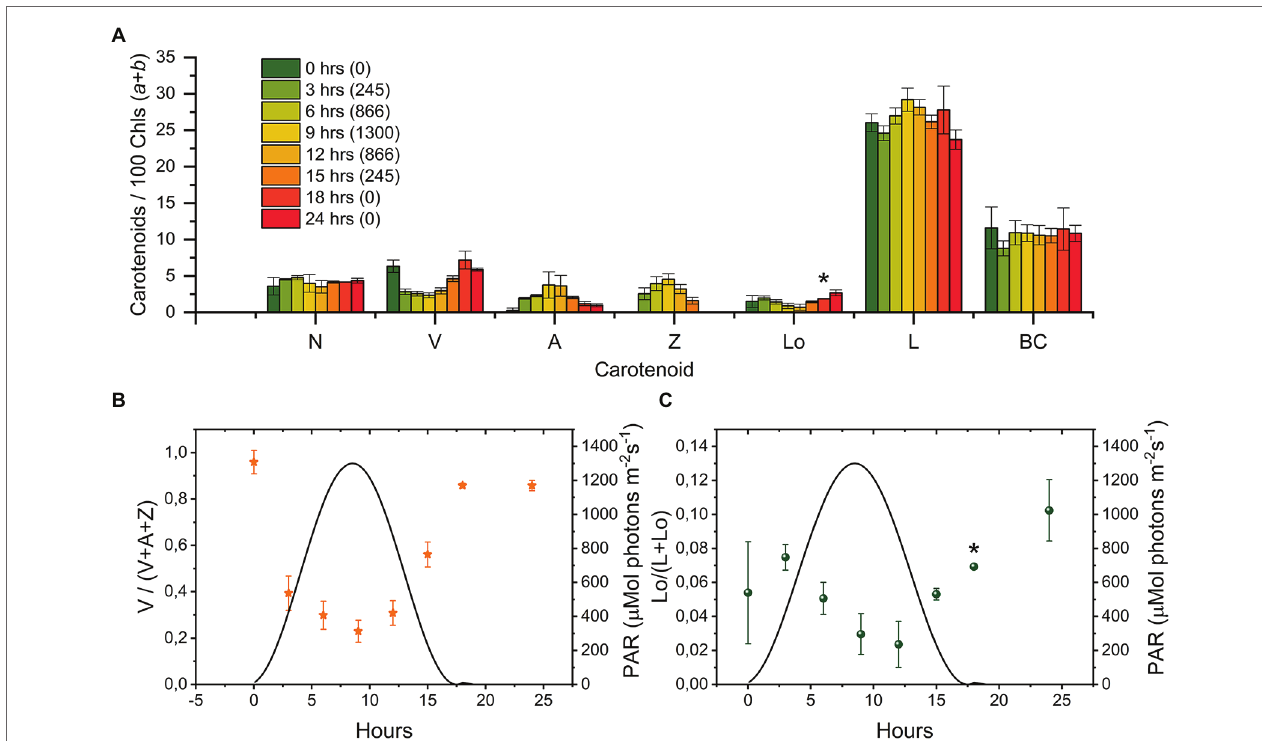
FIGURE 3 | Changes in the carotenoid composition of Chlamydomonas reinhardtii cells during a “simulated summer” day [18:6 (D:N) sinusoidal light regime]. (A) Carotenoid composition relative to 100 Chl ( a + b ) molecules of cultures at different time points (0, 3, 6, 9, 12, 15, 18, and 24 h, the number between brackets in the legend indicates the light intensity in μ mol photons m − 2 s − 1 ). The sample at “0 h” was taken right before dawn. The results are the mean of three biological replicates. The error bar represents the standard error of the mean (SE). (B) Epoxidation state of the VAZ pool. (C) Hydroxylation state of the L-Lo pool. N, Neoxanthin; V, Violaxanthin; A, Antheraxanthin; Z, Zeaxanthin; Lo, Loroxanthin; L, Lutein; and BC, β -carotene. Full statistics are shown in Supplementary Table 1 . *indicate that data from one biological replicate for the protocol that separates neoxanthin and loroxanthin (see M&M) is missing due to loss of sample ( t = 18), while replicates are available also for this time point for all other pigments and for the sum neoxanthin + loroxanthin.